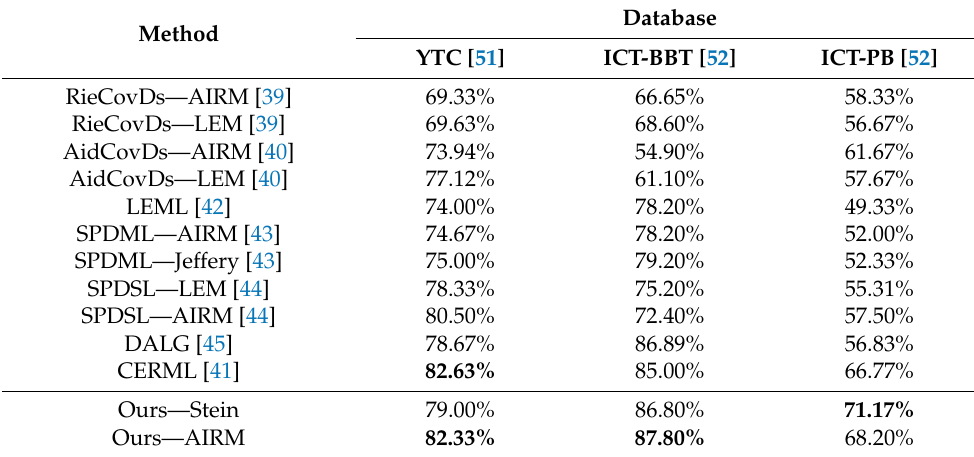
Table 3. Recognition results of comparison